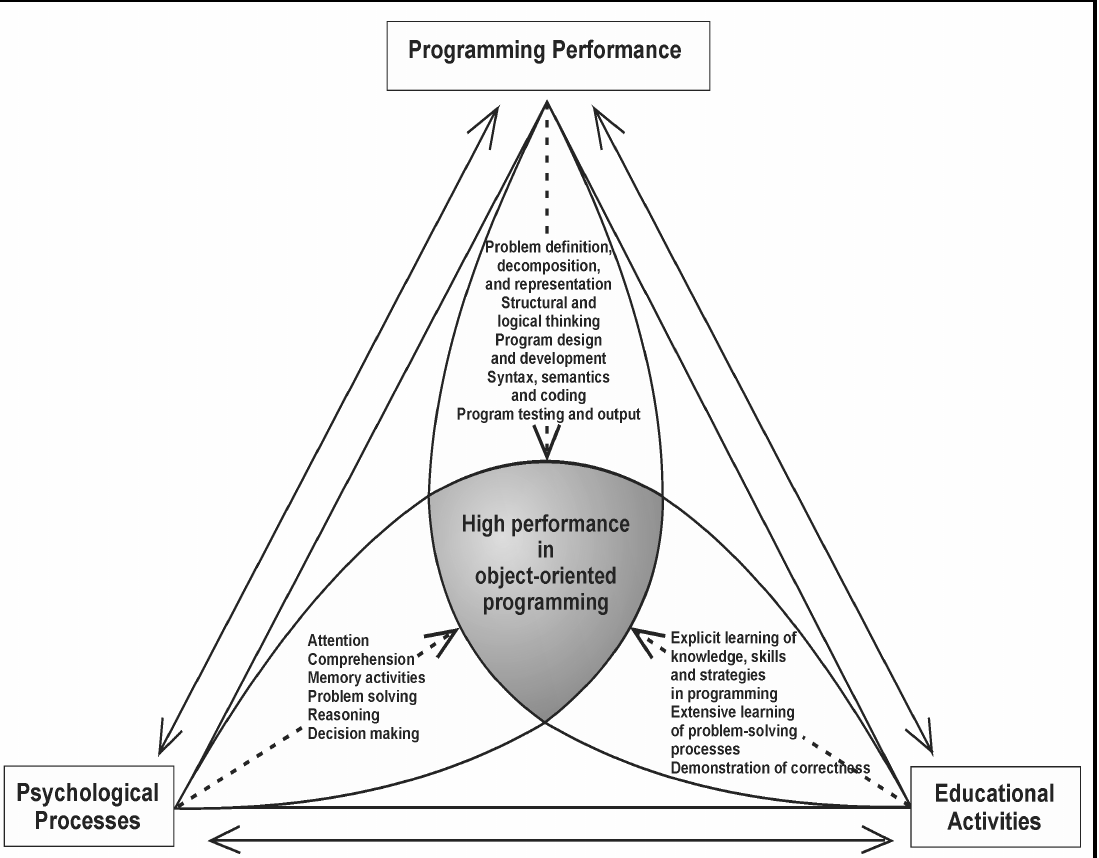
Figure 3: An integrated thinking processes model for learning programming.